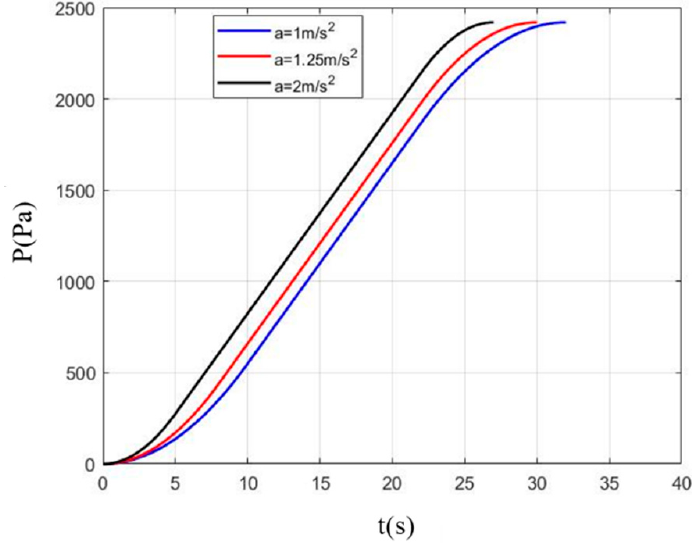
Figure 13. Influence of elevator running acceleration on the air pressure change value inside the car. (3) The influence of elevator lifting